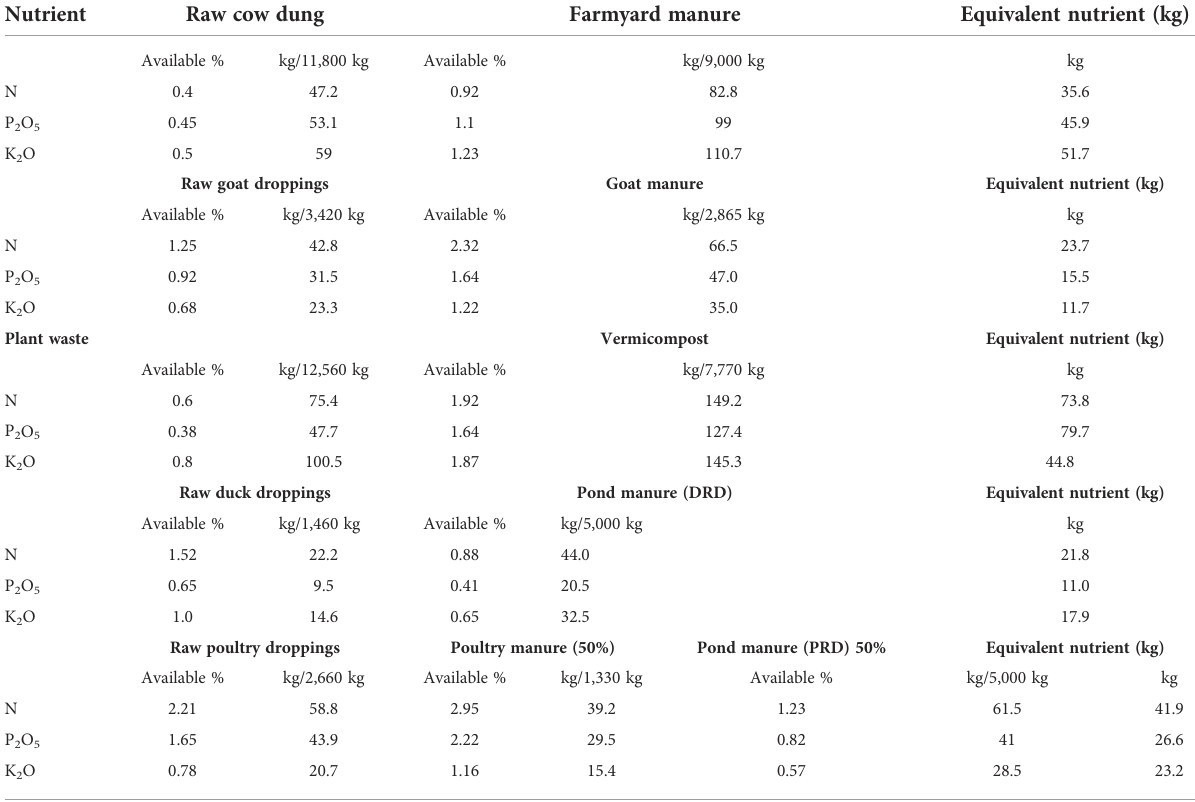
TABLE 6 Nutrient recycling within developed IFS at Patna, Nalanda, and Vaishali (mean value of 6 years: 2016 – 2021). Nutrient Raw cow